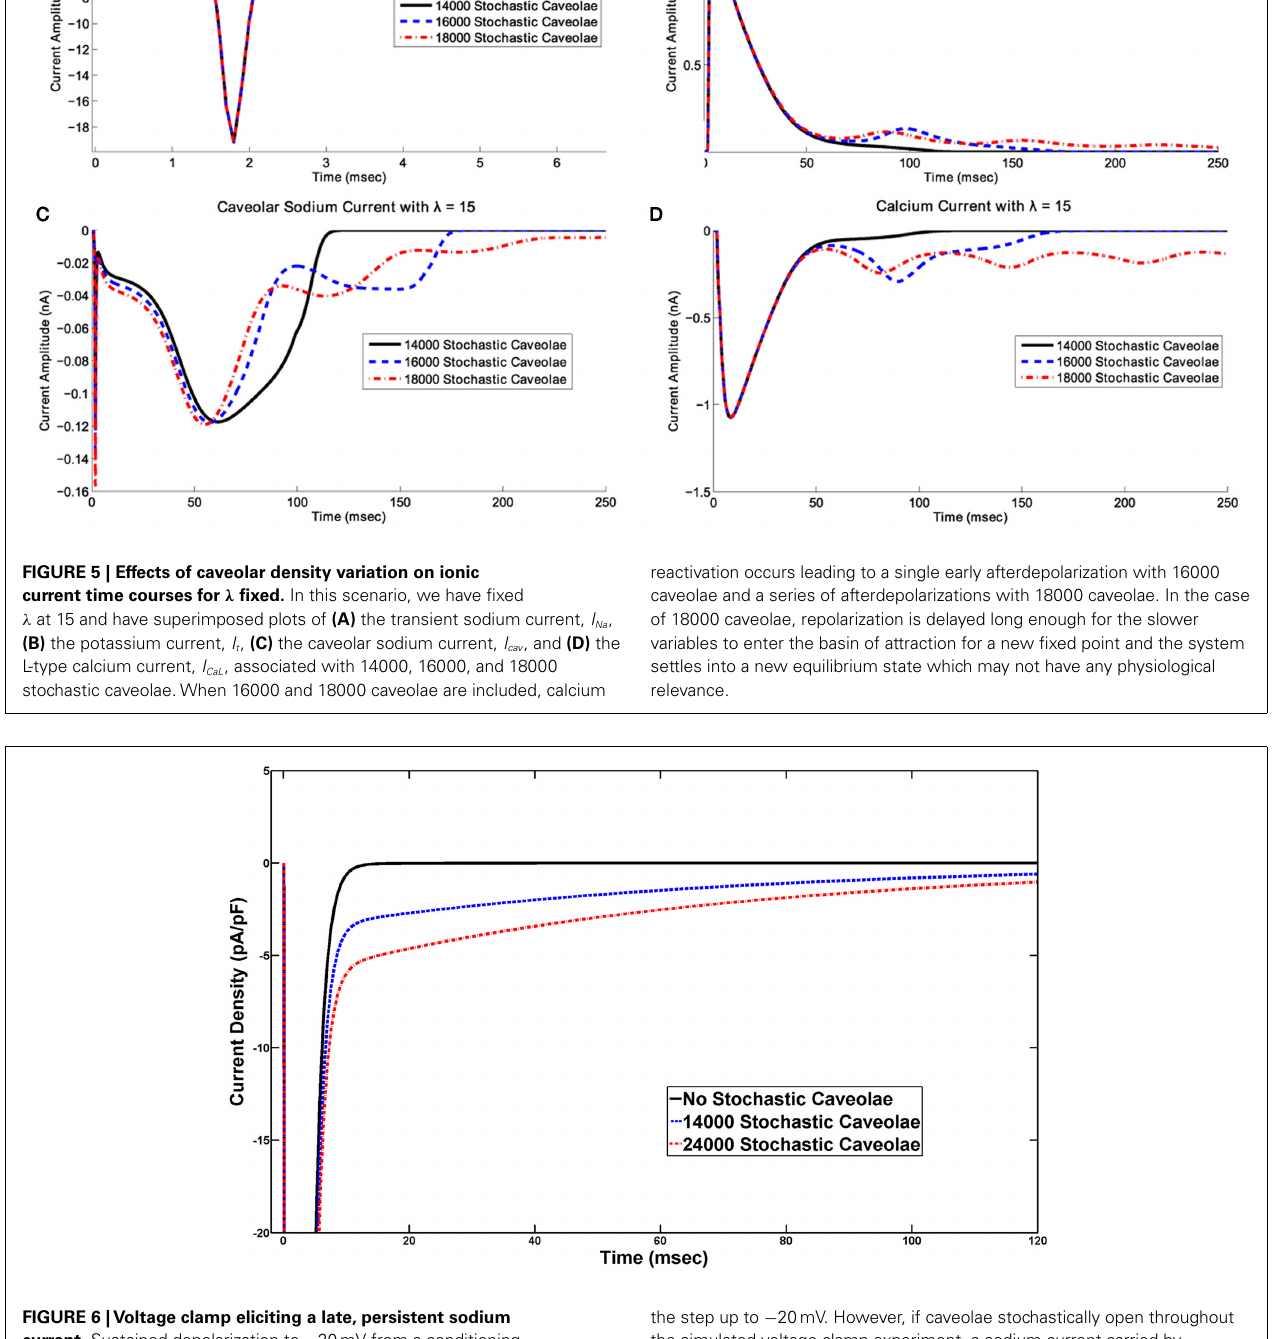
FIGURE 6 |Voltage clamp eliciting a late, persistent sodium current. Sustained depolarization to − 20mV from a conditioning voltage of − 140mV, activates current from sodium channels on the sarcolemma and from sodium channels in any caveolae which open during this sustained depolarization. Under normal conditions in which no caveolae open we see the rapid and complete inactivation of sodium current following